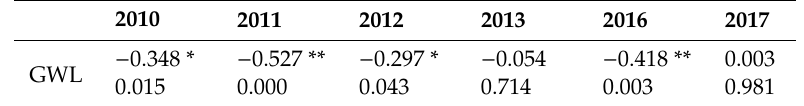
Table 5. Pearson’s correlation coe ffi cient denoting the e ff ect of GWL on NO 3 − concentrations for each year ( n =